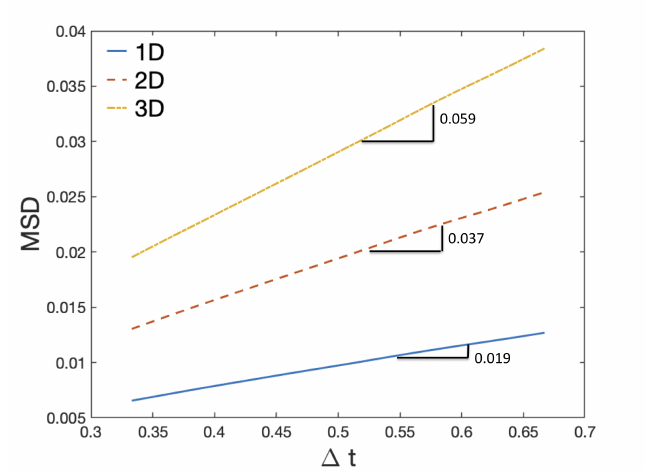
Figure 3. Mean squared displacement (MSD) in 1D, 2D, and 3D. Each line has been fitted to a function of the form y = m x , the best fitting value for the slope m is shown for each line. The slope for 1D is 2 D = 0.019, giving D = 0.0095, the slope for 2D gives 4 D = 0.037 ⇒ D = 0.0093, and for 3D it is 6 D = 0.059 ⇒ D = 0.0098. As a reference, the diffusion coefficient used to generate the particle trajectories is D =